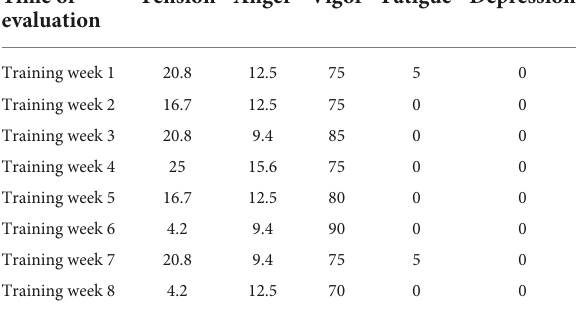
TABLE 4 Values in the POMS factors of Subjetc 2 after